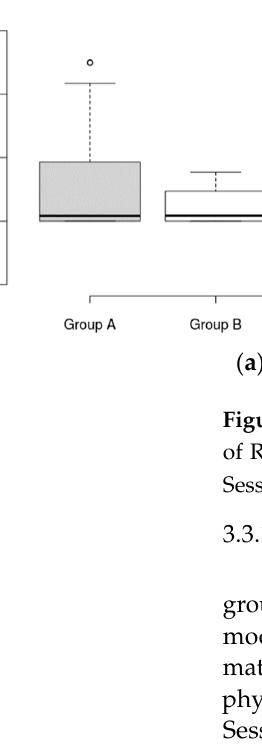
( b ) Figure 4. Box plot to see the distribution of raw EMG values for NP task in Session 1: ( a ) distribution of RBC muscle values of NP task in Session 1 ( b ) distribution of RFCR muscle values NP task in Session 1.